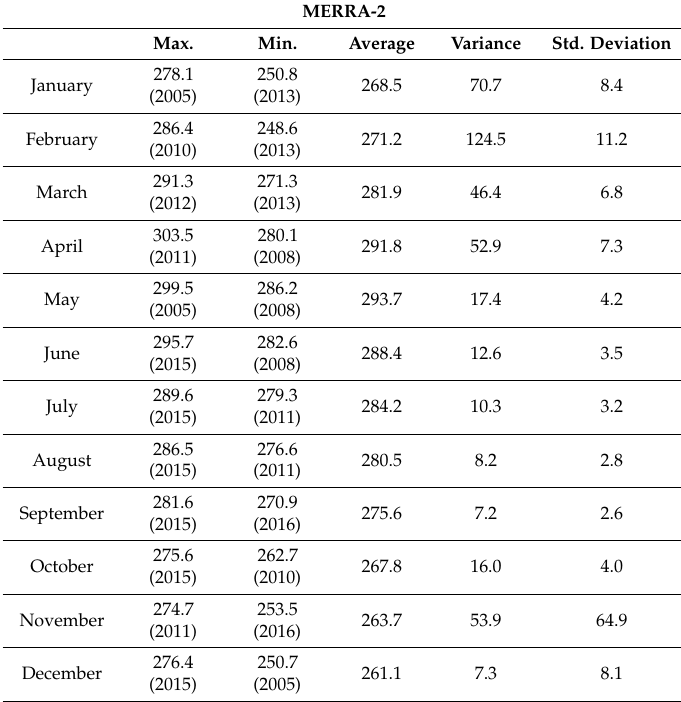
Table 4. Interannual monthly regional average statistics TOC for 12 years from MERRA-2. Numbers in parentheses represent the corresponding